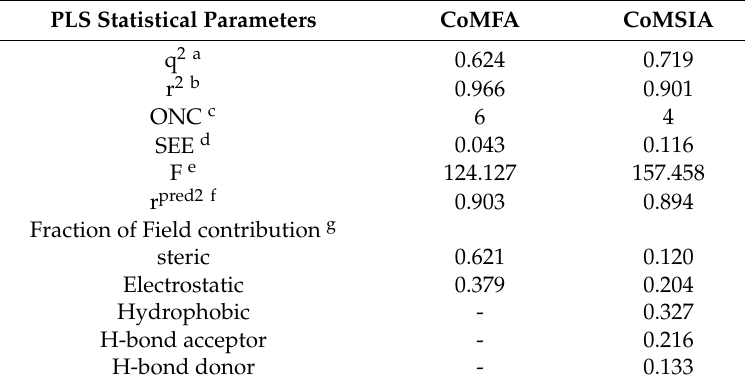
Table 1. The partial least square (PLS) statistical parameters for the CoMFA and CoMSIA.